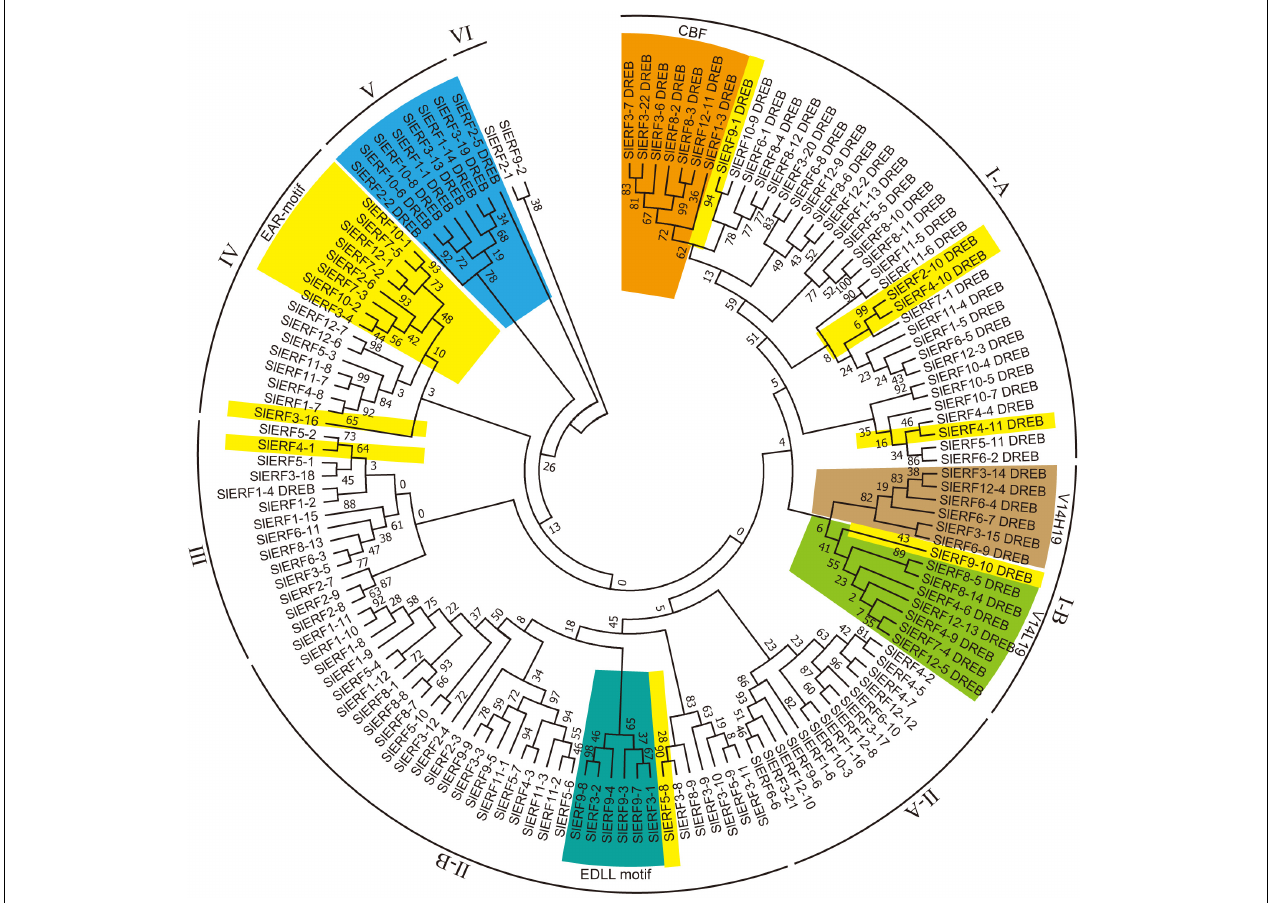
FIGURE 1 | Phylogenetic analysis of 60 DREB and 80 ERF proteins in tomato. Blue, DREB proteins in group V; yellow, EAR motif-containing proteins; orange, CBF proteins; emerald green, EDLL motif-containing proteins; yellow green and latin yellow, respectively indicate DREB proteins with V14L19 and V14H19. Maximum likelihood method was used to structure phylogenetic tree based on the Whelan and Goldman model of MEGA v7.0 (Whelan and Goldman, 2001), parameters: JTT + G model, partial deletion with 80% site coverage cutoff, and 1,000 bootstrap replications (Kumar et al.,